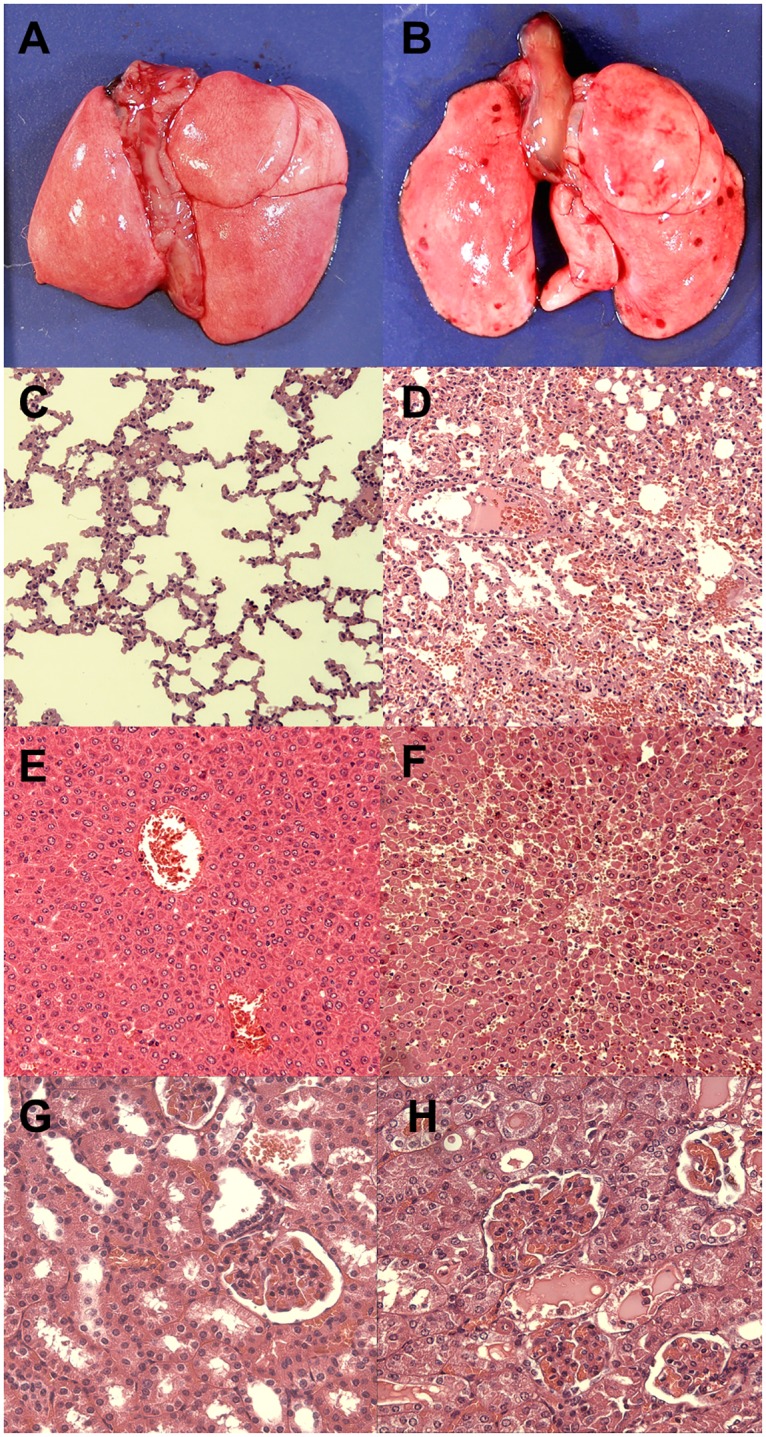
Pathological findings in the hamster model.Animals vaccinated with rLigB(131–645) (A, C, E and G) or the PBS control group (B, D, F and H) were euthanized 10 days PC and tissue samples were collected. Vaccinated animals showed no gross pulmonary lesions (A) or microscopic pulmonary lesions (C). Liver (E) and kidney samples (G) showed no evidence of microscopic abnormalities. Unvaccinated animals showed gross pulmonary haemorrhaging (B) and they were confirmed to be alveolar haemorrhages by microscopic analysis (D). Dystrabeculaton (loss of cohesion) of hepatocytes (F) and swelling of kidney tubular epithelial cells (H) were prominent features. (C-F, haematoxylin-eosin, 100× magnification and G-H, haematoxylin-eosin, 200× magnification).